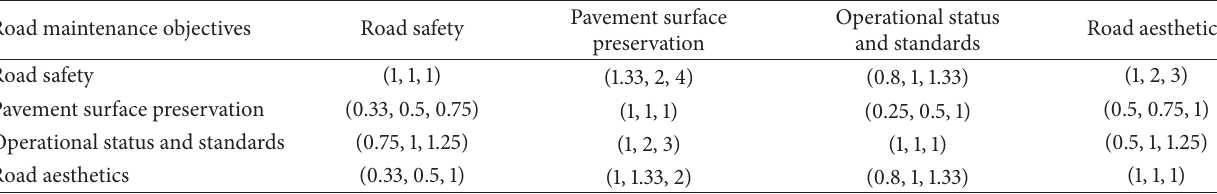
Table 9: Equivalent fuzzy based evaluation matrix for maintenance objectives.